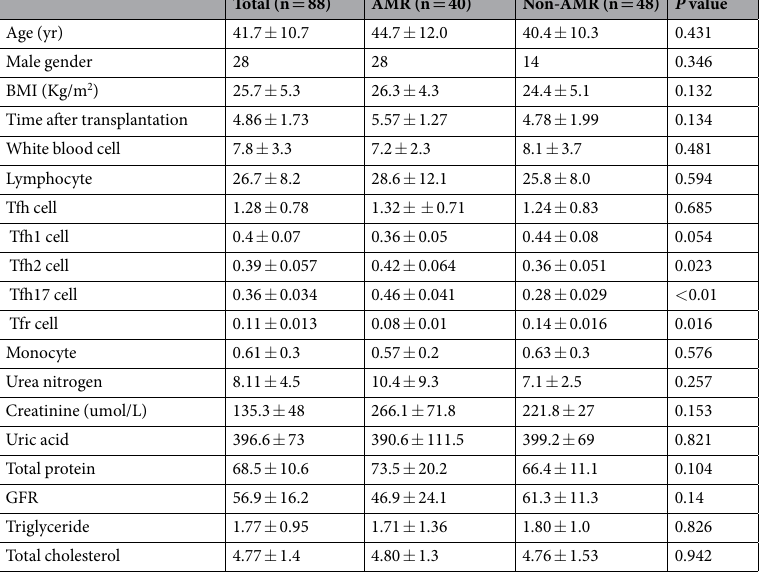
Table 1. The baseline and clinical characteristics of CRAD patients in renal